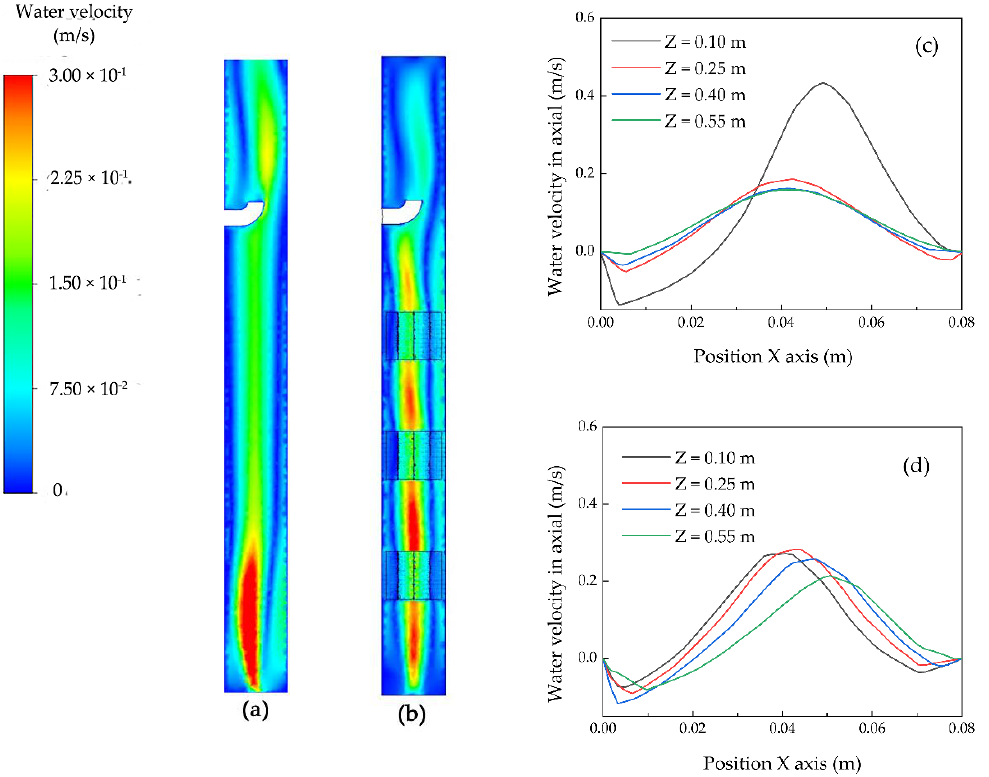
Figure 9. Comparison of fluid velocity distribution in axial between unpacked and packed columns: ( a ) Contour of no packing; ( b ) Contour of packing three layers; ( c ) Line chart of no packing; ( d ) Line chart of packing three layers.